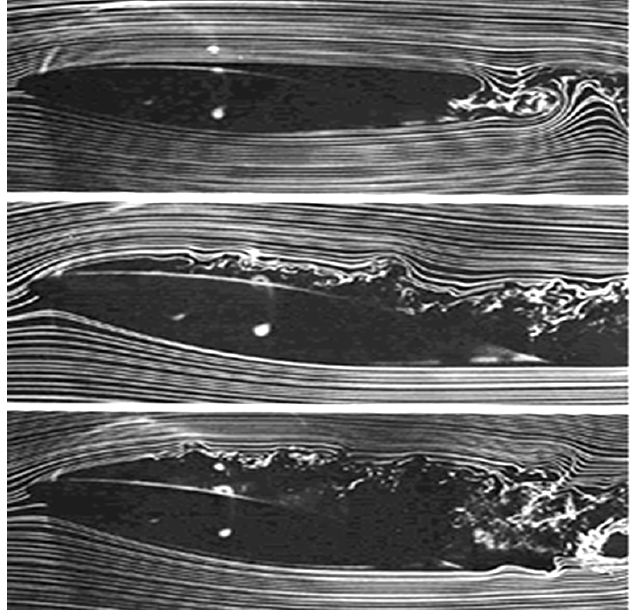
Figure 1. Increasing flow separation as yaw angle increases [14]. (Reprinted with permission from [14]. Copyright 2012 Prentice